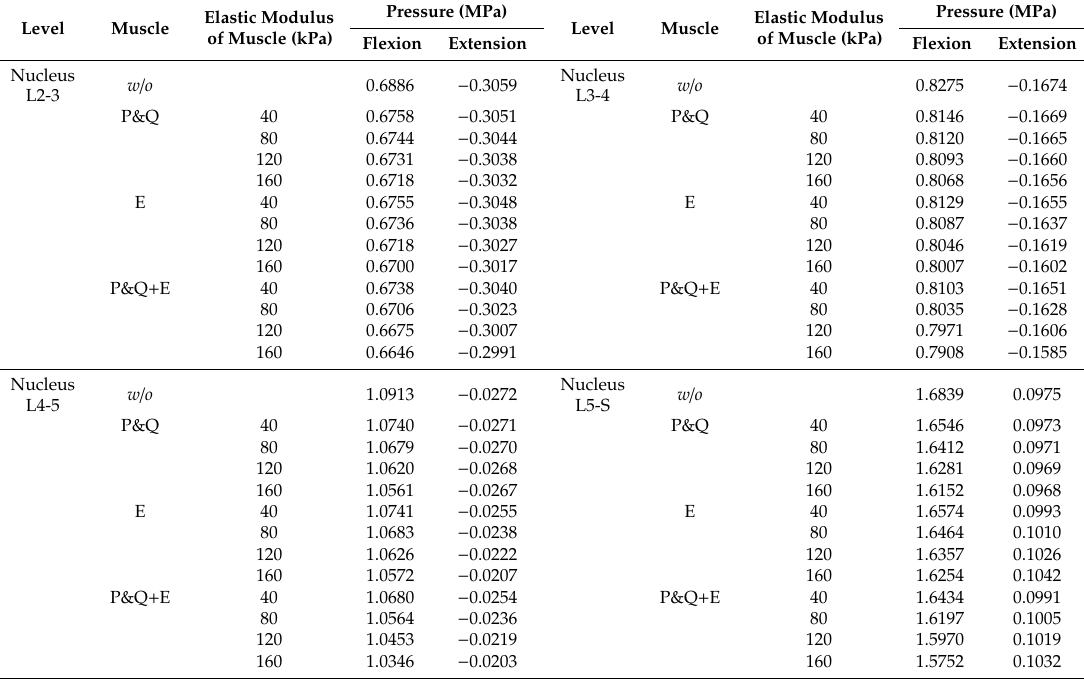
Table 4. Intradiscal pressure of various models with various elastic modulus of